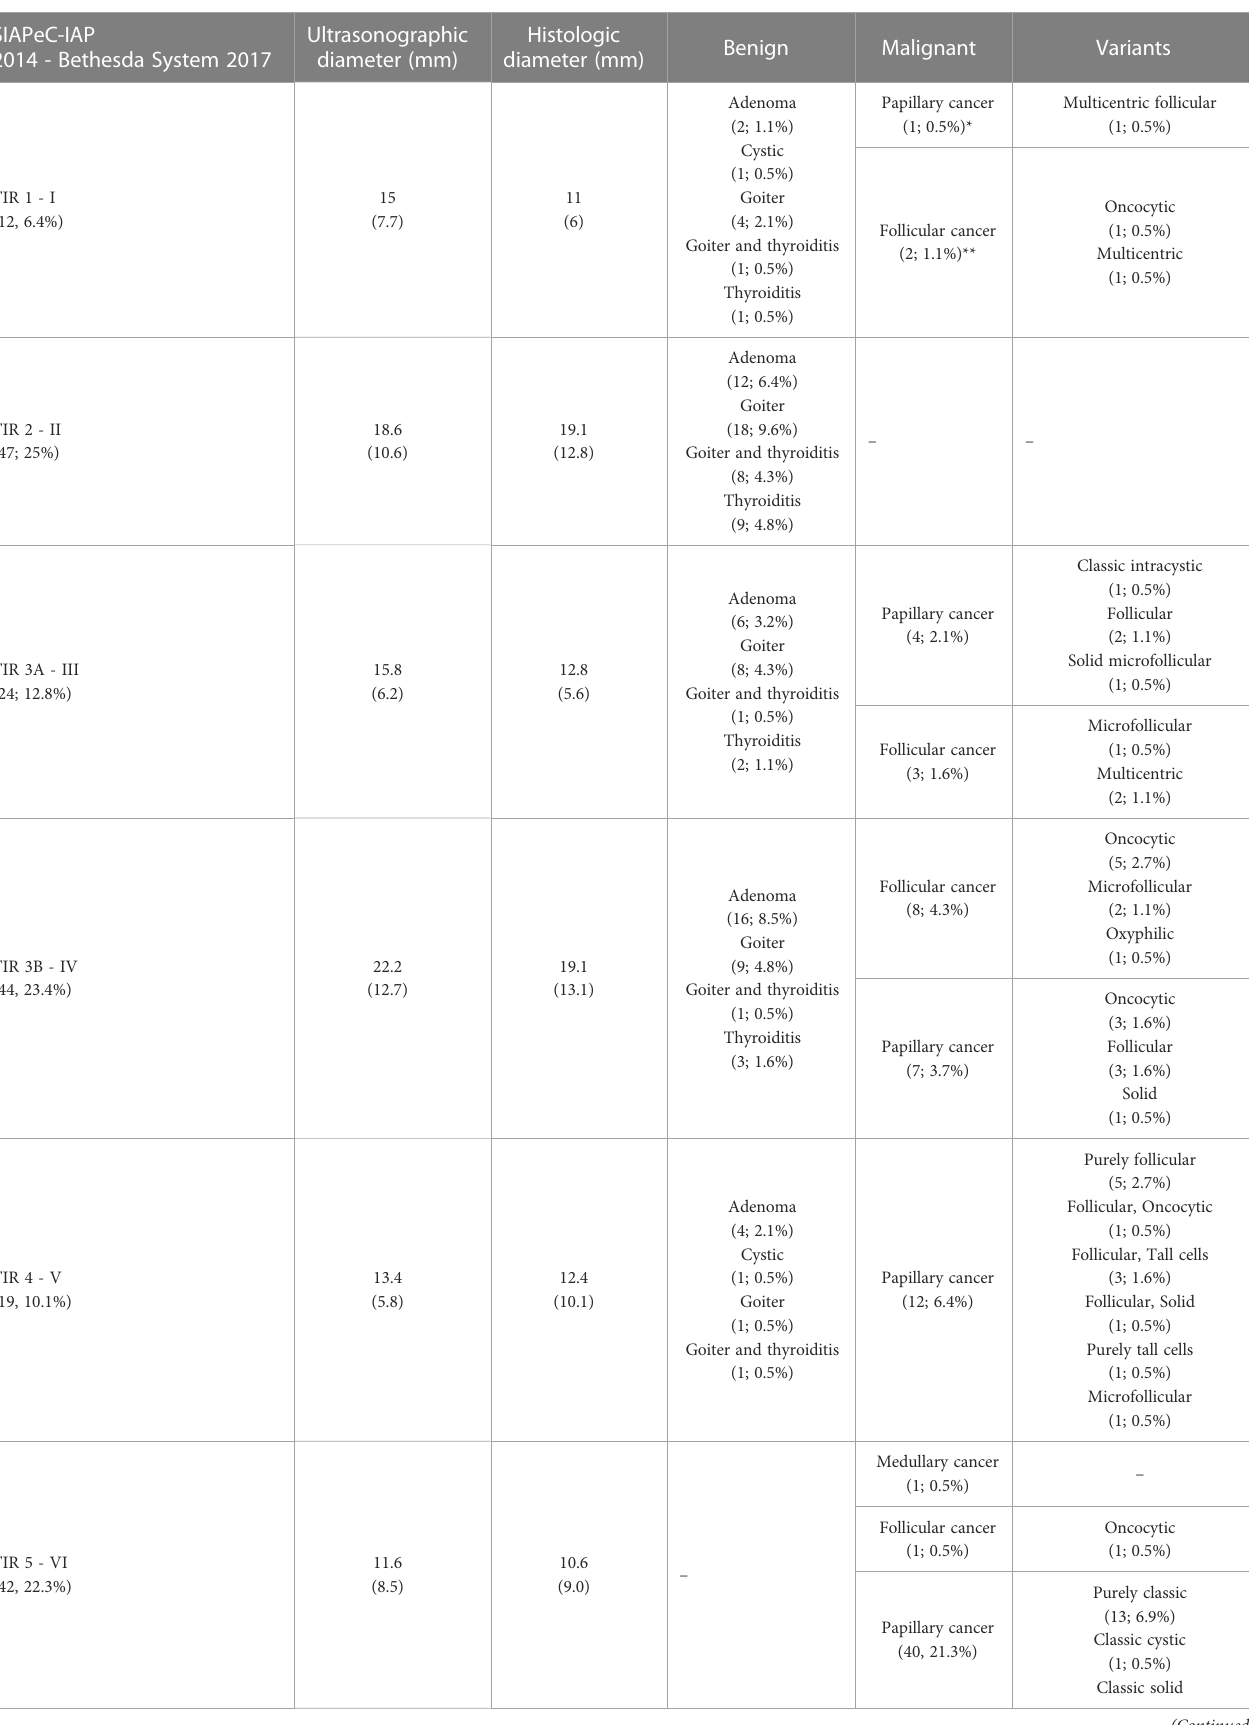
TABLE 2 Descriptive statistics of cytological fi ndings and histological corresponding (n =